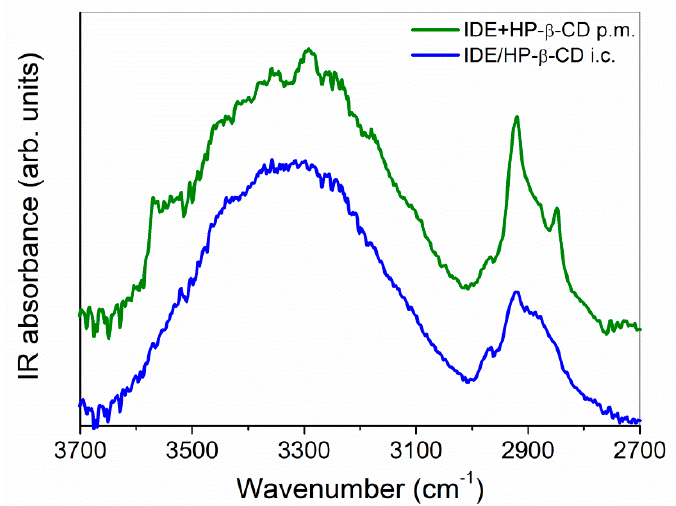
Figure 3. Fourier-transform infrared spectroscopy in attenuated total reflectance geometry (FTIR-ATR) spectra, in the 3700 − 2700 cm − 1 mid-infrared spectral range, of IDE + HP- β -CD physical spectra, in the 3700–2700 cm − 1 mid-infrared spectral range, of IDE + HP- β -CD physical mixture (p.m., mixture (p.m., green line) and IDE/HP- β -CD inclusion complex (i.c., blue line), at T = 300 K as an green line) and IDE / HP- β -CD inclusion complex (i.c., blue line), at T = 300 K as an example. IR: example. IR: infrared.